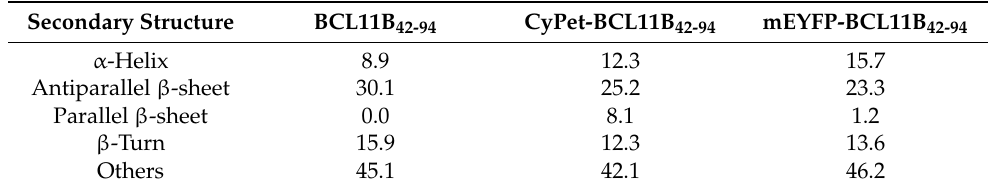
Figure 4. Characterization of the fluorescent BCL11B 42-94 zinc finger domain. Secondary structure determination of ( A ) untagged BCL11B 42-94 ( B ) and CyPet-BCL11B 42-94 using circular dichroism showing raw (black) and fitted data (red). ( C ) CD spectra of BCL11B 42-94 before (black) and after (red) removing zinc. After adding Zn 2+ again, the spectrum resembles one of a typically folded zinc finger again. ( D ) FRET of the CyPet-BCL11B 42-94 and mEYFP-BCL11B 42-94 oligomers. Donor quenching is indicated by an arrow pointing downwards, while increasing the fluorescence of mEYFP-BCL11B 42-94 is marked by an arrow pointing upward. ( E ) Size exclusion chromatography of CyPet-BCL11B 42-94 with an elution volume of CyPet-BCL11B 42-94 at 1.35 mL corresponding to a larger oligomer formation. ( F ) SEC of untagged BCL11B 42-94 . The elution at 1.64 mL corresponds to complexes around the tetramer size. Table 1. Secondary structure content of BCL11B 42-94 and its fluorescent constructs. Deconvolution was carried out using BeStSel.com (accessed on 18 July 2021) [25,26]. The secondary structure content is shown in percentage (%). Deconvolution of BCL11B 42-94 after the TEV digest of mEYFP- BCL11B 42-94 is shown in Table